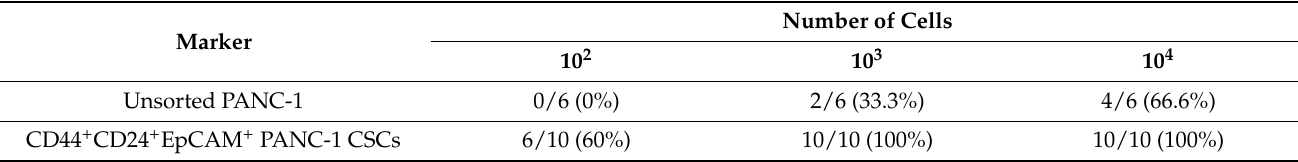
injected with PANC-1 cells and CD44 + CD24 + EpCAM + PANC-1 CSCs; *, p < 0.05; **, p < 0.01. Table 1. Tumor formation ability of sorted CD44 + CD24 + EpCAM + pancreatic CSCs isolated from the human PANC-1 pancreatic cell line.